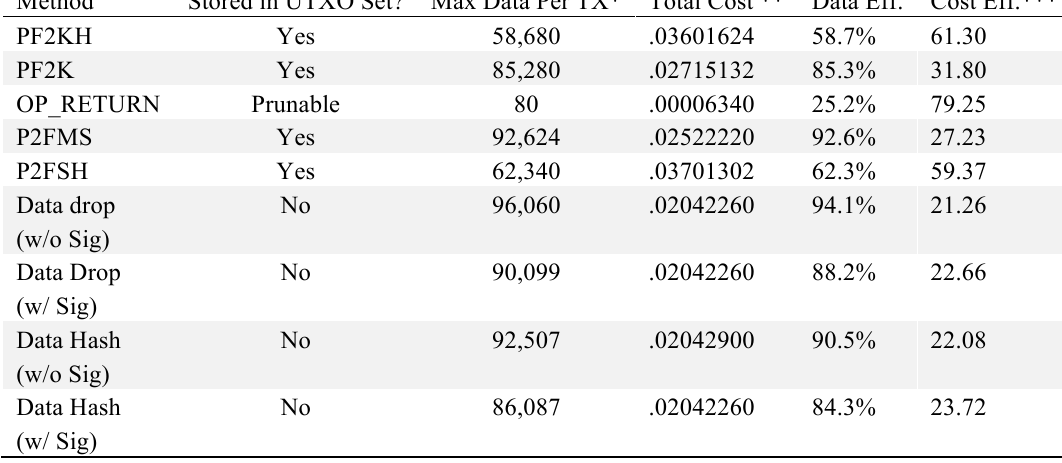
Table 3. Method Summary (Max Size and Cost) for a Fee of 20